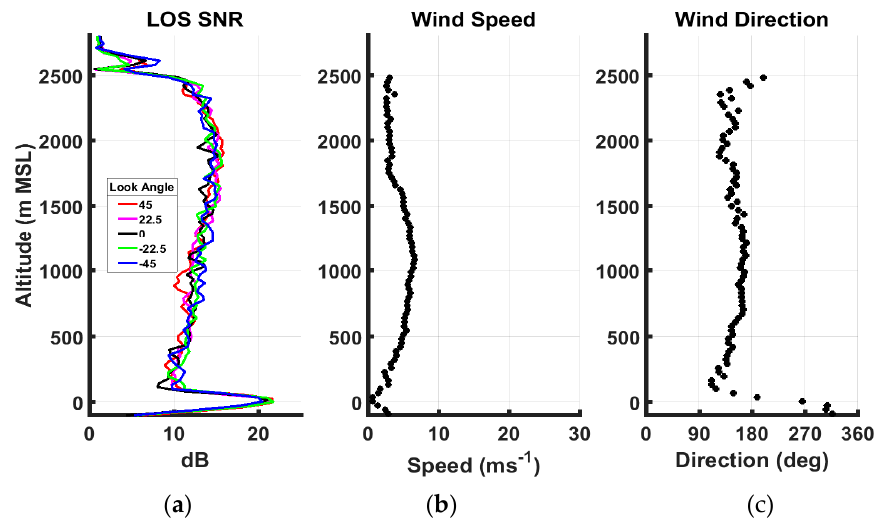
Figure 7. DAWN profiles of SNR ( a ), wind speed ( b ) and wind direction ( c ) on 1 June 2017 at 171233Z over the Florida peninsula.